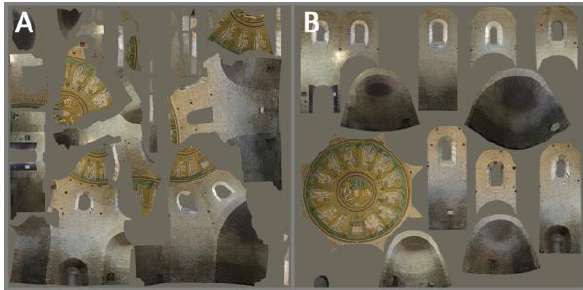
Figure 9. A) product of automatic parameterization. B) automatic parameterization of Low-Poly mesh from retopology